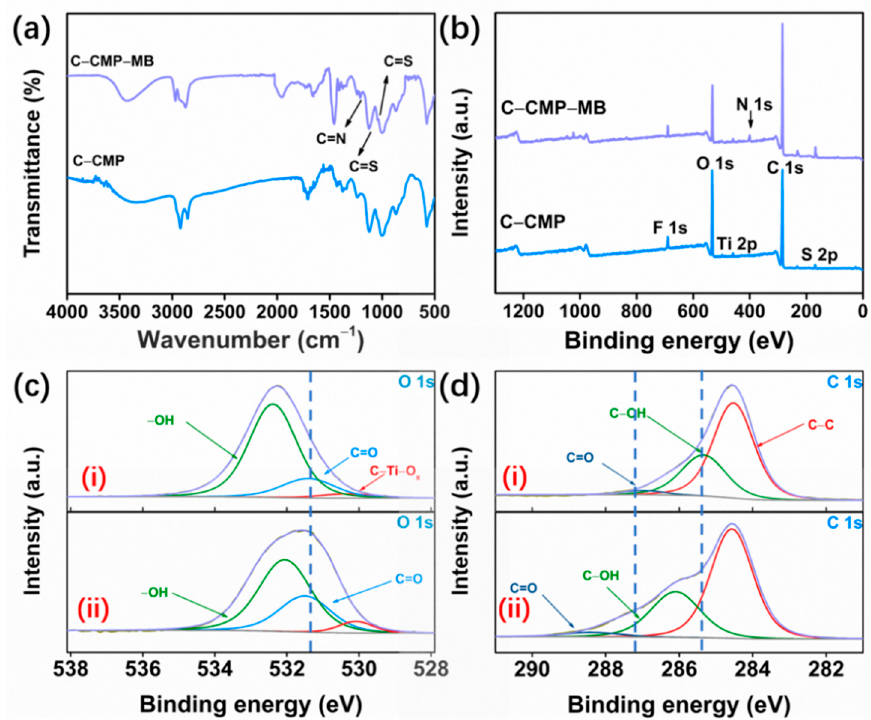
Figure 5. ( a ) FT–IR spectra of the fresh C–CMP and C–CMP after MB removal (C–CMP–MB). Figure 5. ( a ) FT − IR spectra of the fresh C − CMP and C − CMP after MB removal (C − CMP − MB). ( b ) ( b ) X-ray photoelectron spectra (XPS) of C–CMP and C–CMP–MB. ( c ) O 1s scans of C–CMP ( i ) and X − ray photoelectron spectra (XPS) of C − CMP and C − CMP − MB. ( c ) O 1s scans of C − CMP (i) and C–CMP–MB (ii). ( d ) C 1s scans of C–CMP ( i ) and C–CMP–MB ( ii C − CMP − MB (ii). ( d ) C 1s scans of C − CMP (i) and C − CMP − MB (ii).